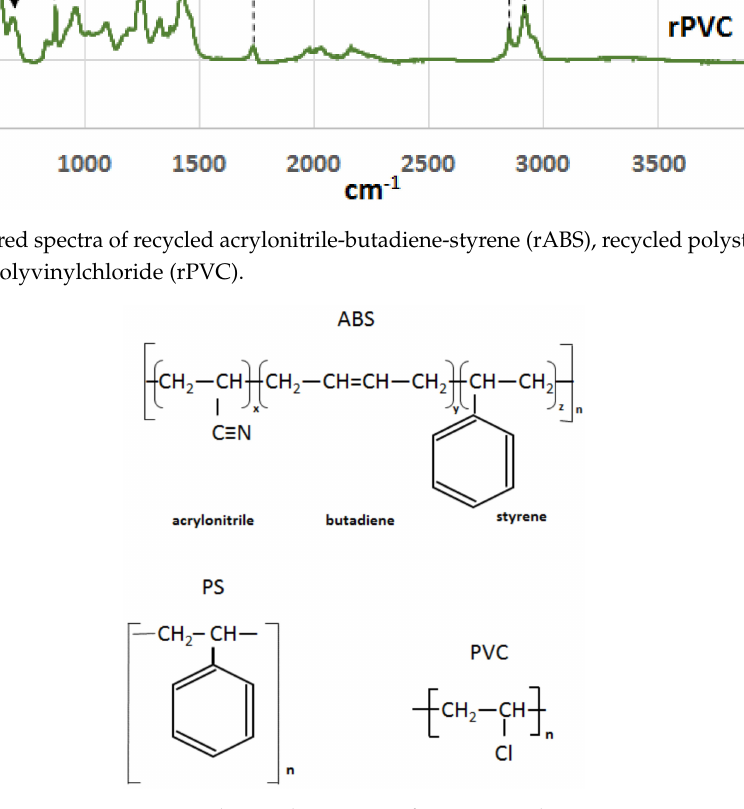
Figure 2. Chemical structure of ABS, PS and PVC. Elemental composition of rABS, rPS and rPVC, wt.%; standard deviation is given in